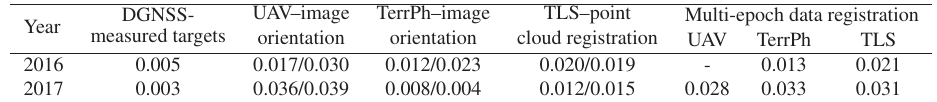
Table 2. Accuracy assessment for the data acquisitions in June 2016 and 2017, expressed as: single standard deviation of DGNSS measurements, RMSE (XY/Z) [m] on CPs after image triangulation, RMSE [m] of point-to-plane distances of the single laser scans/RMSE [m] for fitting the reconstructed spheres’ centres to the respective coordinates measured by DGNSS, and RMSE [m] of multi-epoch point clouds registration.